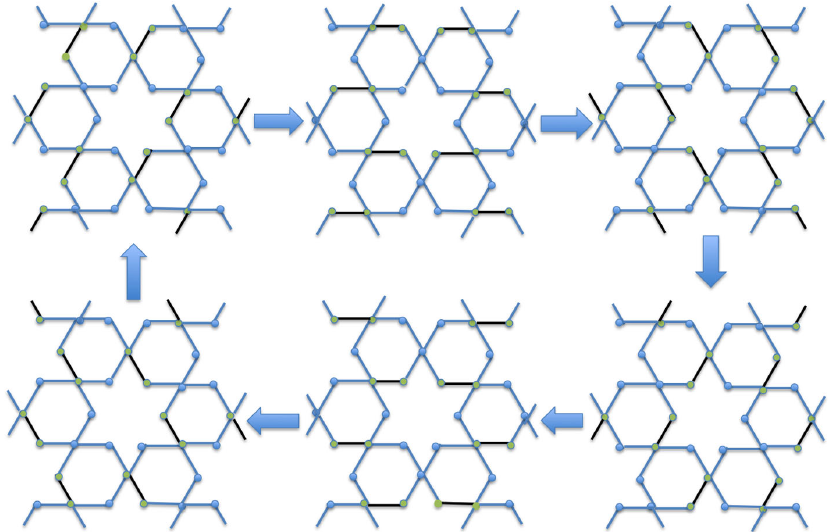
FIG. 14. An example measurement protocol on a “ modified ” kagome lattice that utilizes six measurement steps (as opposed to the eight-step procedure used on the Lieb lattice). The black bonds indicate free hopping pairs and measurement is indicated by blue colored